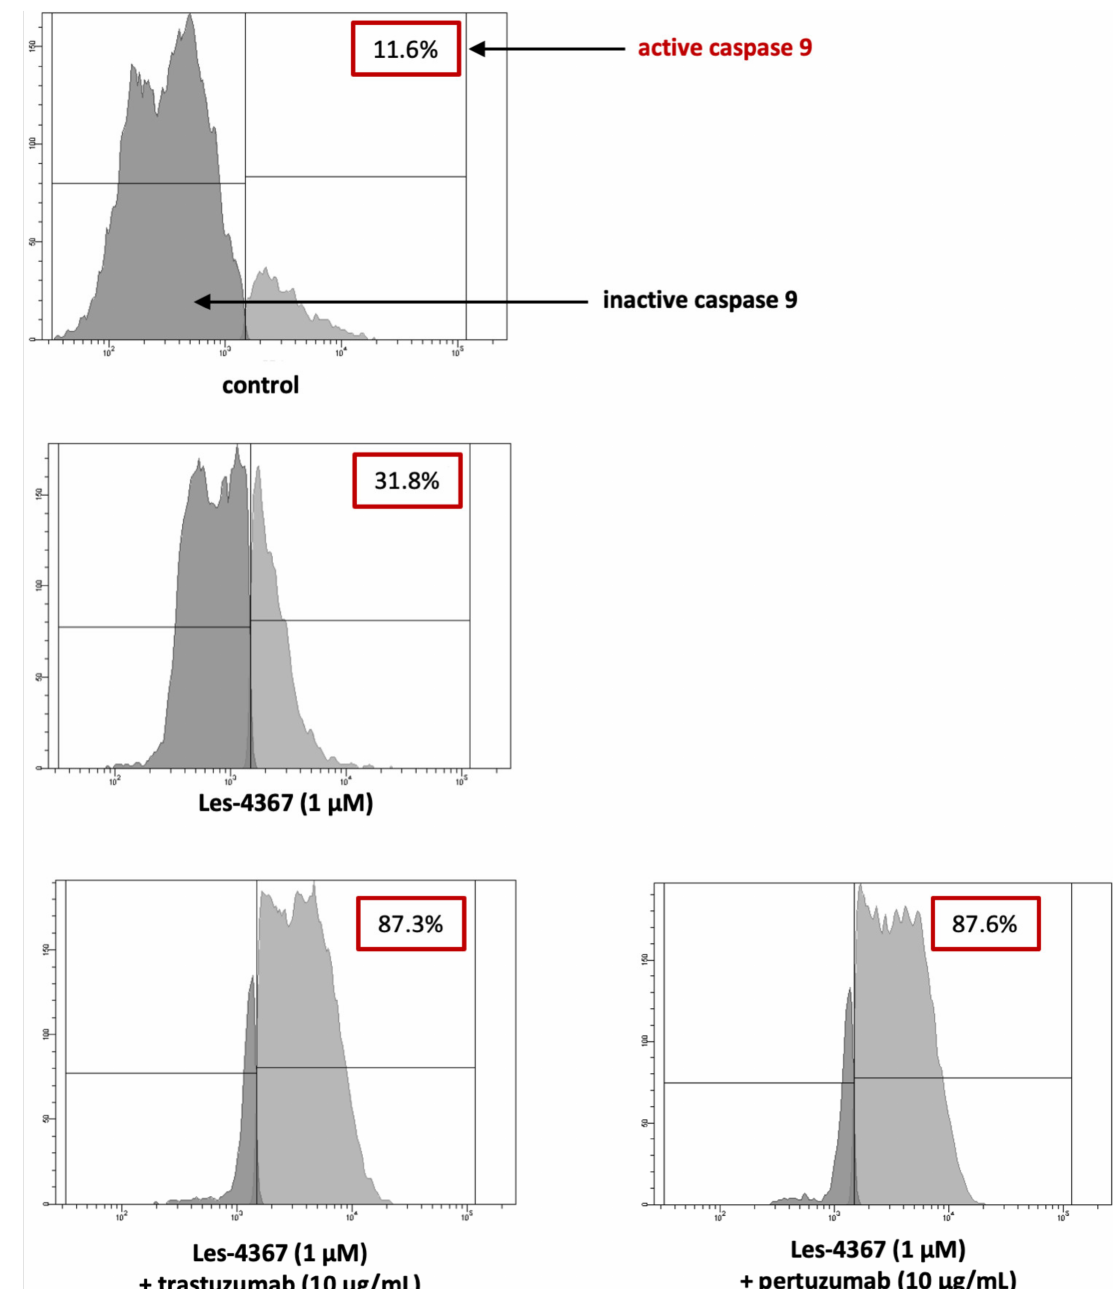
Figure 5. Activity of caspase-9 in AGS cells after 24 h incubation with Les-4367 (1 µ M) and combined with anti-HER2 antibodies. Dark grey part of histogram- cells with inactive form of caspase-9, light grey part of histogram- cells with active form of caspase-9. The ANOVA and Tukey tests were used to demonstrate differences between the control cells and the cells exposed to varying concentrations of the tested